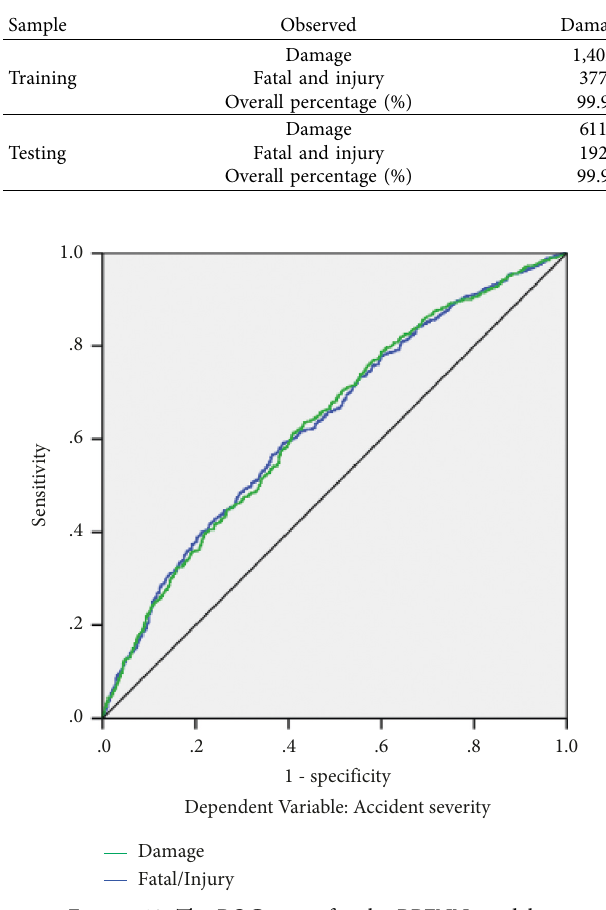
Figure 12: The ROC curve for the RBFNN model.